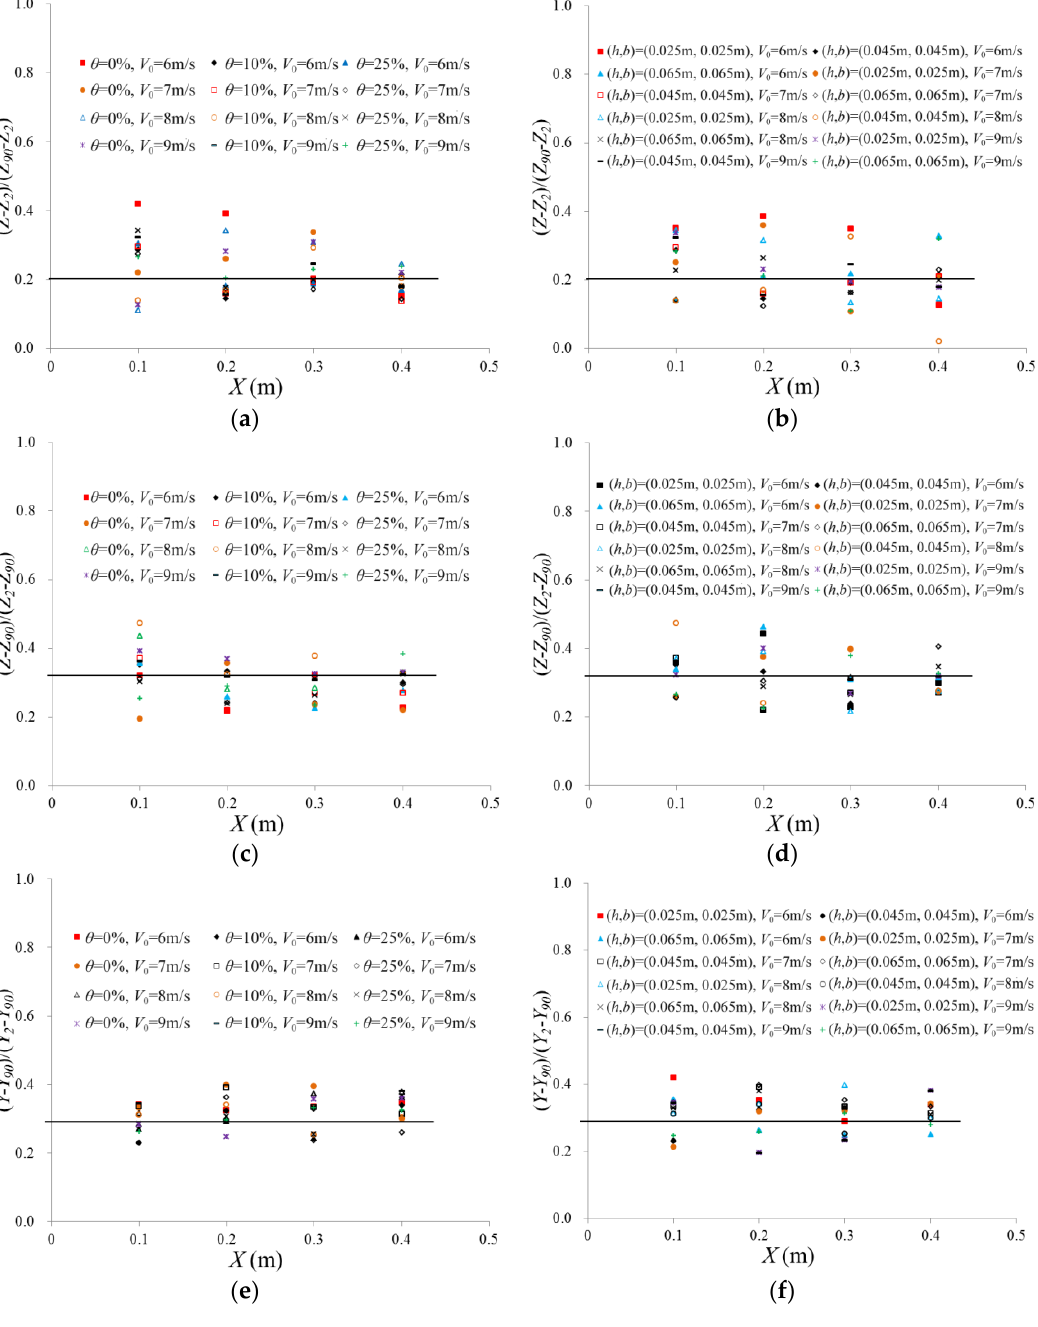
Figure 10. Relative location corresponding to the maximum dimensionless air bubble frequency. Upper nappe ( a ) ( h , b ) = (4.5 cm, 4.5 cm). ( b ) θ = 10%; lower nappe ( c ) ( h , b ) = (4.5 cm, 4.5 cm). ( d ) θ = 10%; side nappe ( e ) ( h , b ) = (4.5 cm, 4.5 cm). ( f ) θ = 10%.